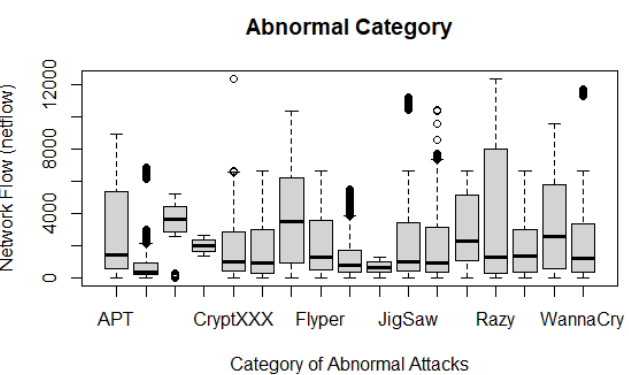
Figure 26. The proportion of abnormal malware in the UGRansome.